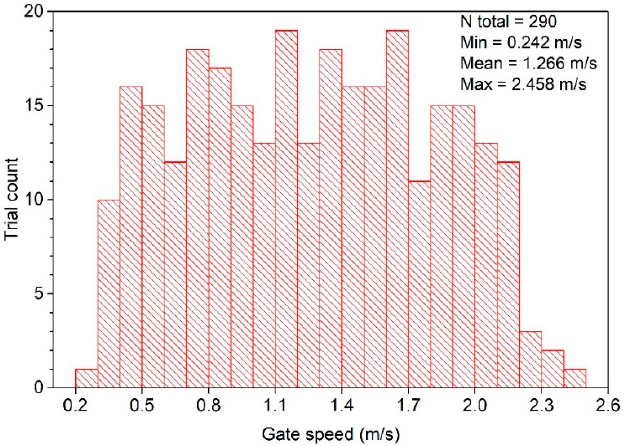
Figure 2. Test count histogram in terms of gate speed over a range of 0.20–2.50 m/s.